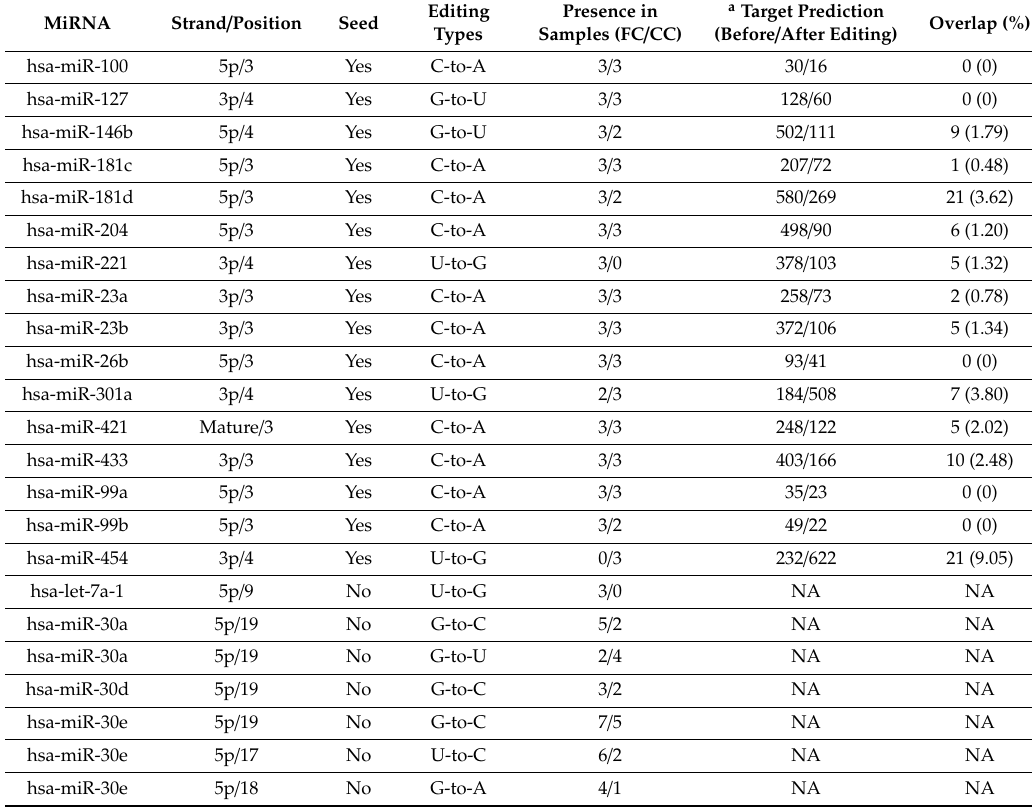
Table 1. Target prediction analysis of non-canonical miRNA editing events present in at least three FC and CC